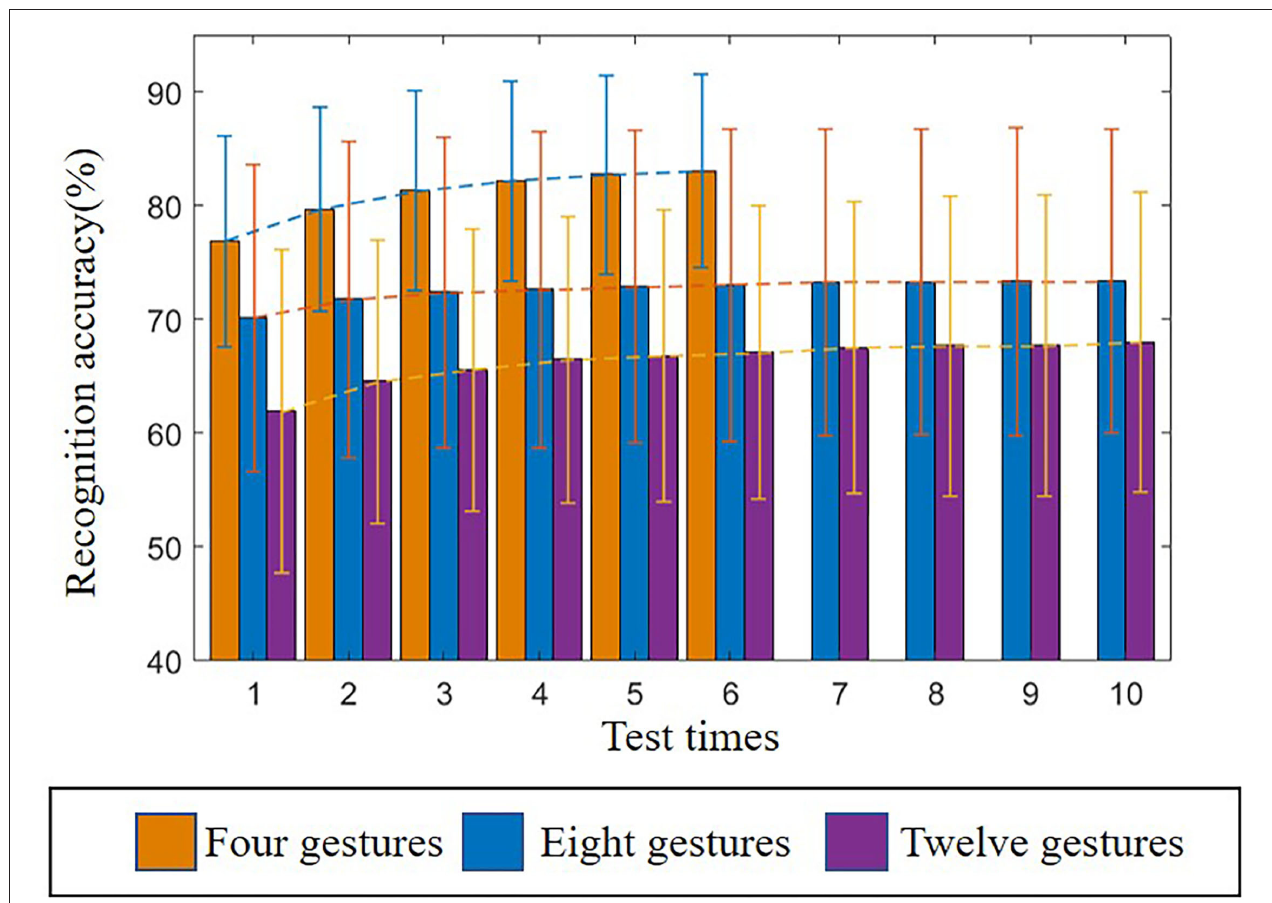
FIGURE 7 | Relationship between average recognition accuracy and test